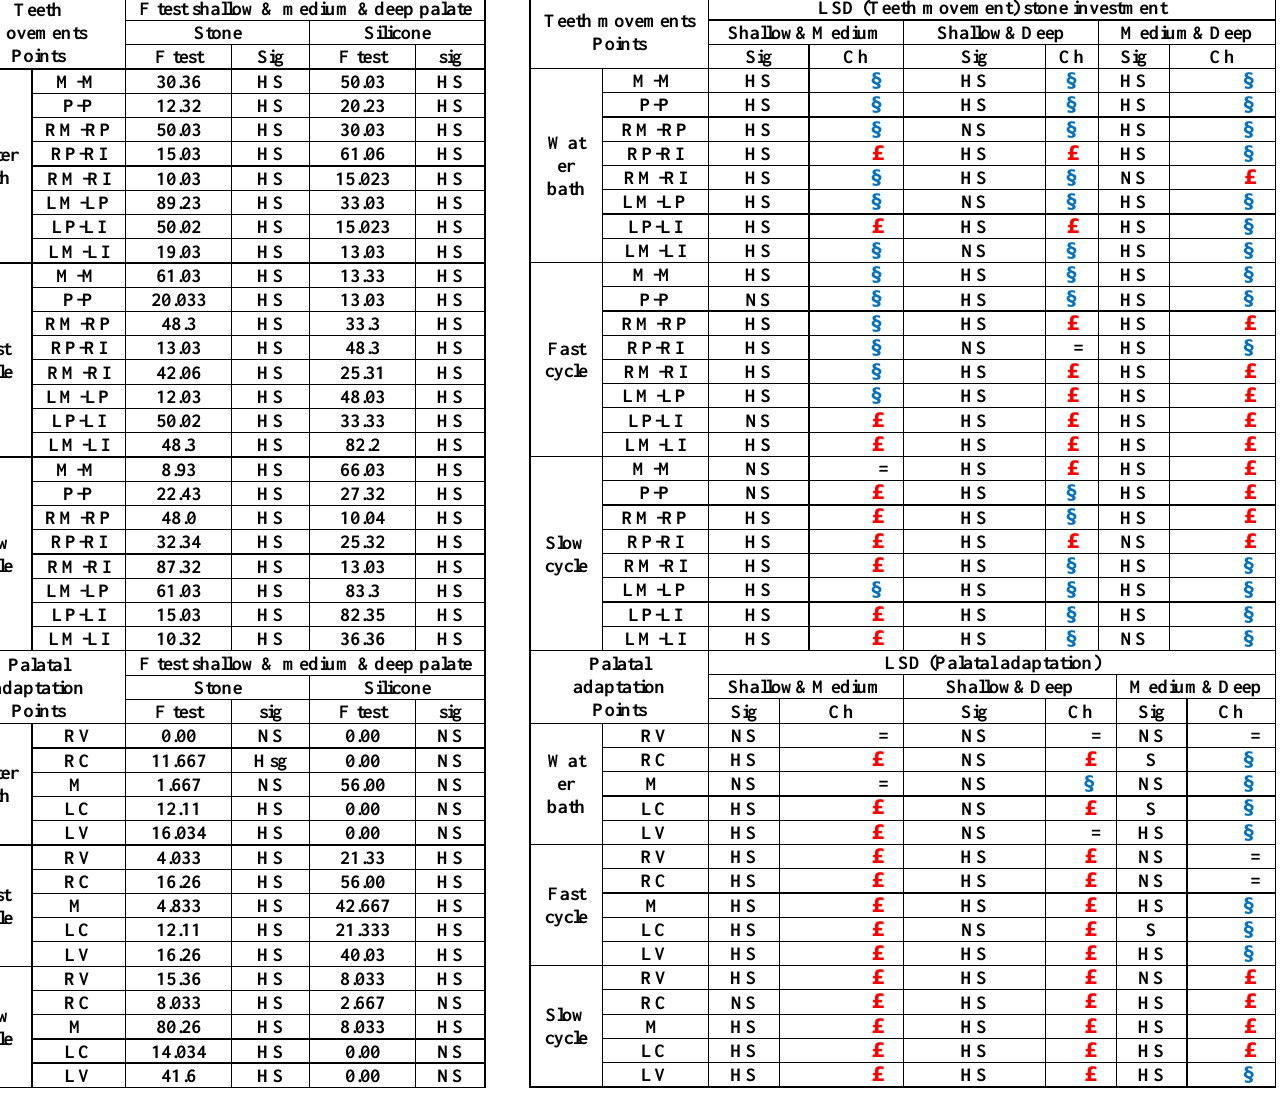
Table 2: the F test for comparison between curing methods and investments with palatal depths for both teeth movements and palatal adaptation.